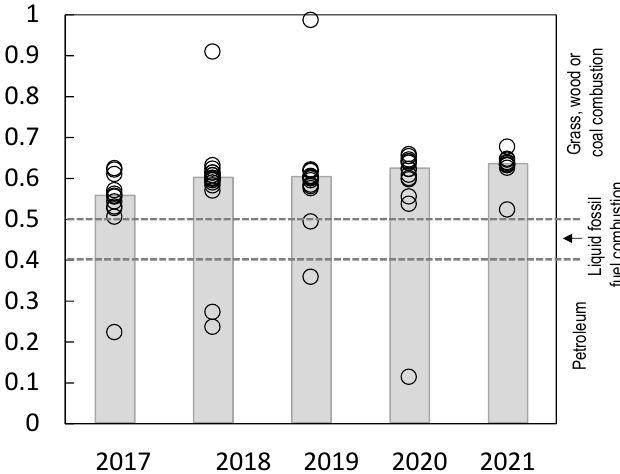
Figure 10. Behaviors in the diagnostic ratio of the forest site using all data of each year. The bar graphs represent the median values.